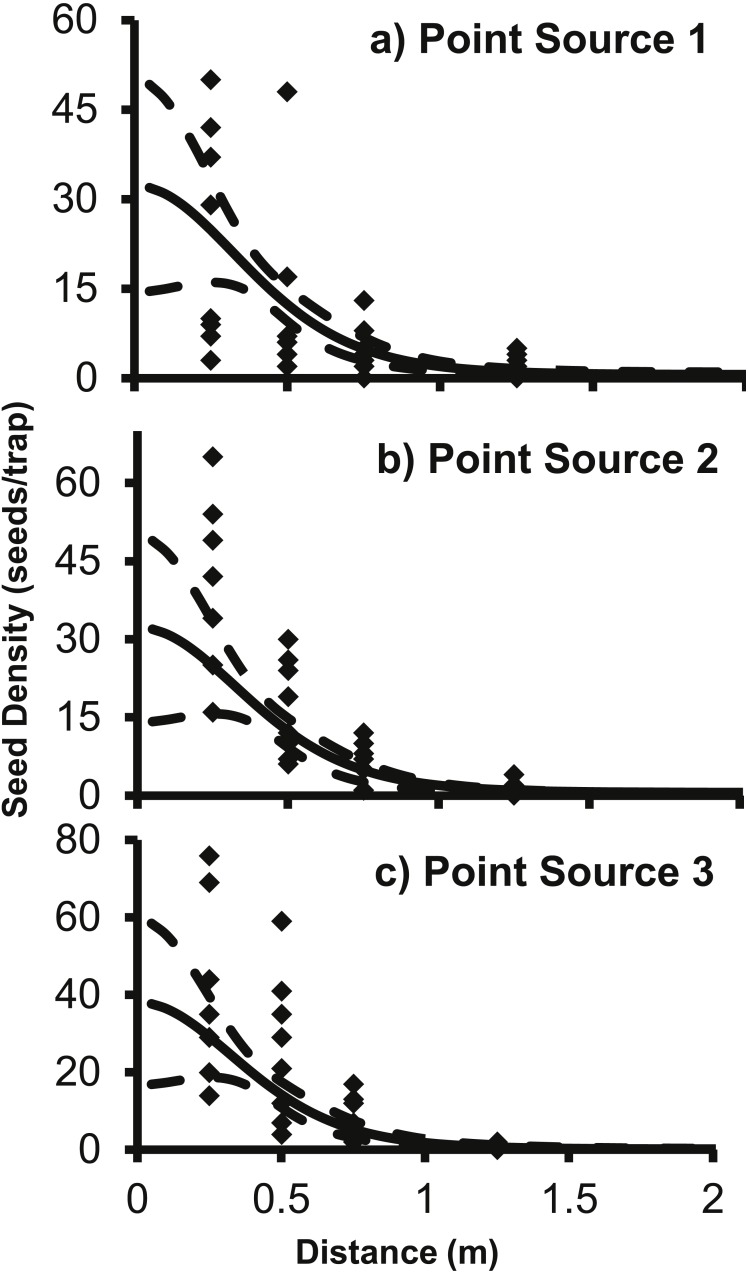
The predicted seed count per trap (solid line) ± 95% confidence intervals (dashed lines) for 2Dt function for each point source, (A) Point Source 1, (B) Point Source 2, and (C) Point Source 3.Each of the point sources was plotted separately and the black diamonds are the seed counts from the seed traps.